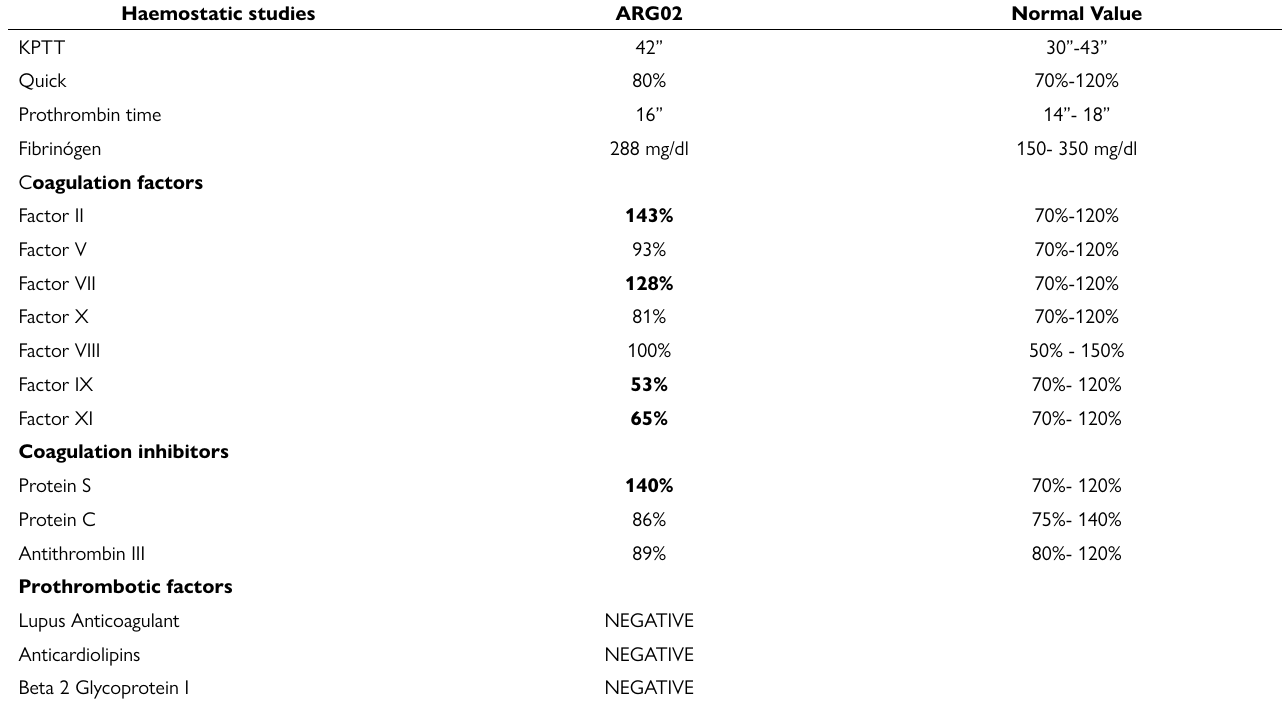
Table 2. Haemostatic’s determinations in PMM2-CDG